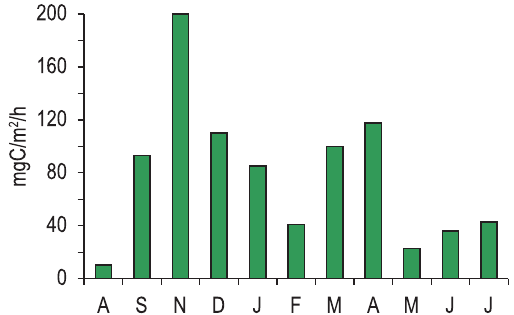
Figure 6. Productivity rates per area, from August 1998 to July 1999.